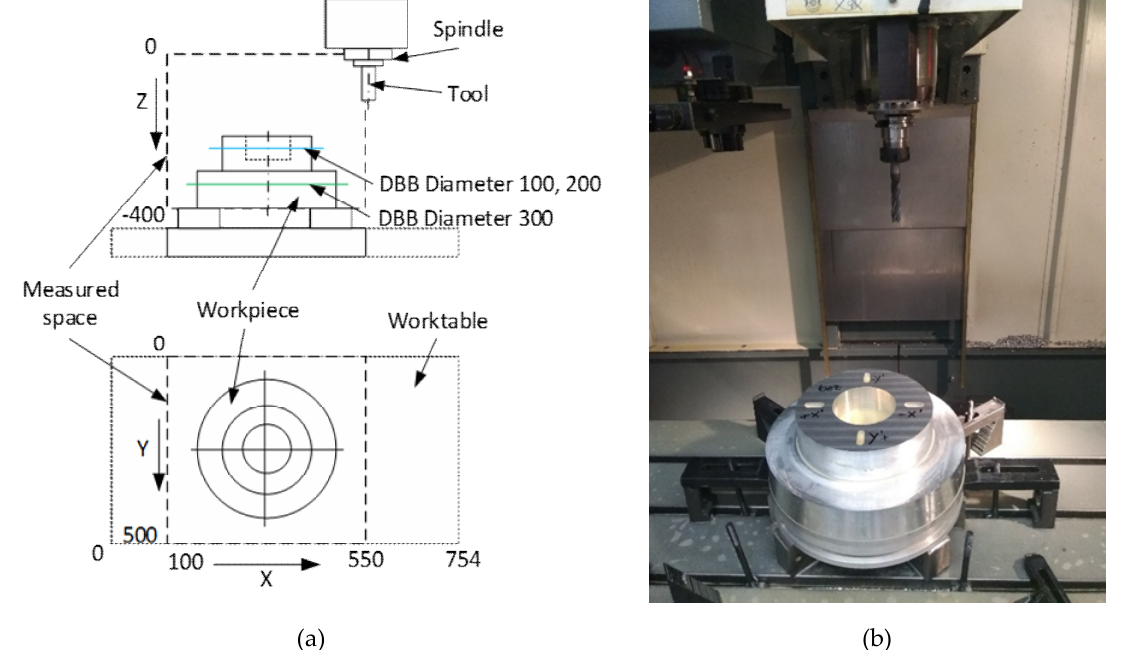
Figure 2. Machining of the test workpiece. ( a ) Position of the workpiece in the machine; ( b ) workpiece machining.